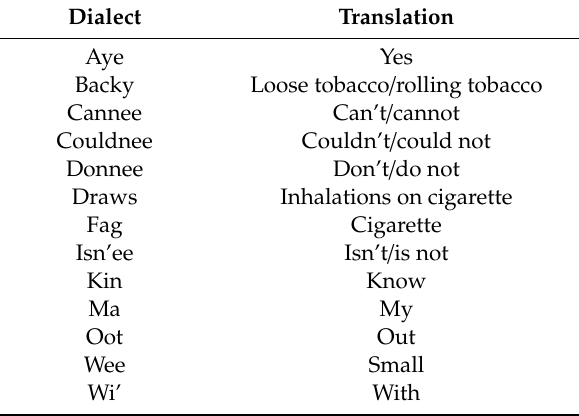
Table A1. Glossary for dialect used in participant